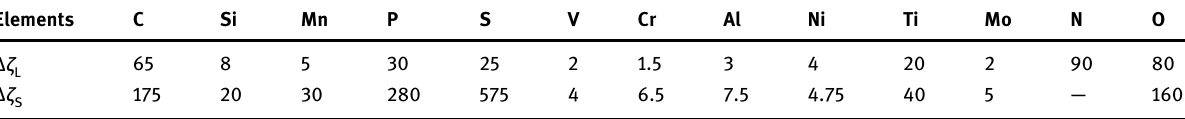
and ζ Δ corresponded to the solute elements shown in Table 1 [ 30,31 ] L S